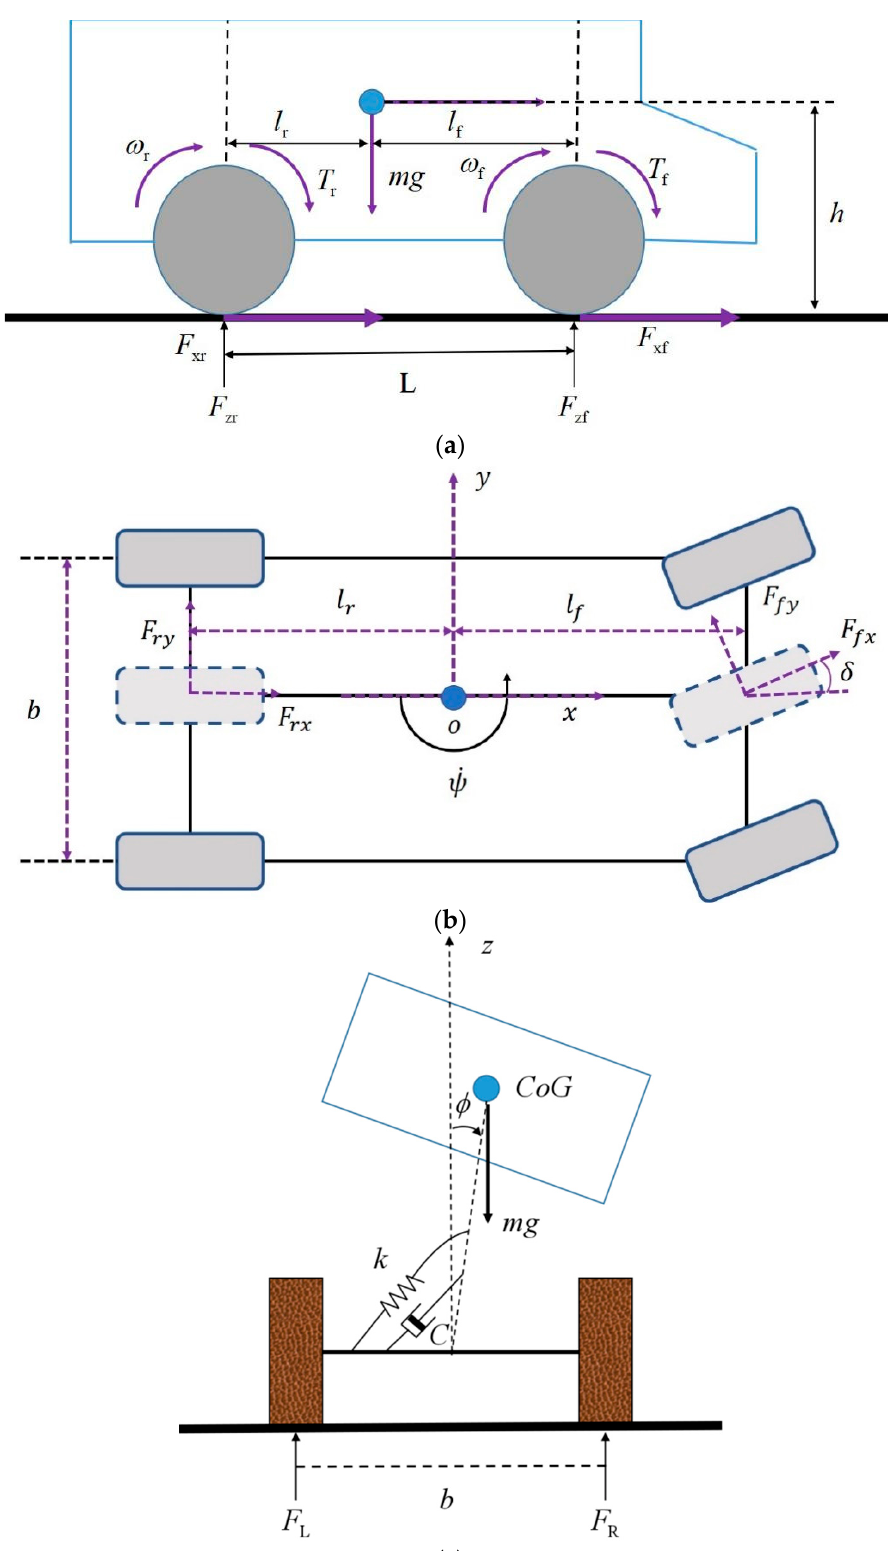
Figure 2. Vehicle model: ( a ) Longitudinal vehicle dynamics model; ( b ) Single-track vehicle model; ( c ) Vehicle roll dynamics .